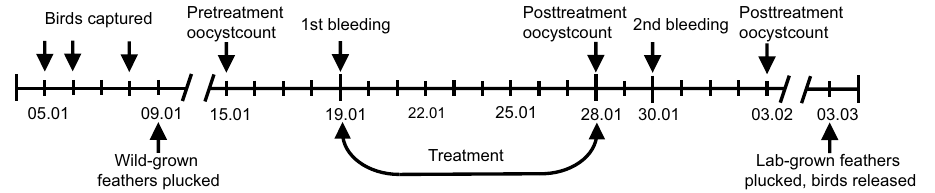
Figure 1. Timeline of the experiment. The dates are in DD/MM